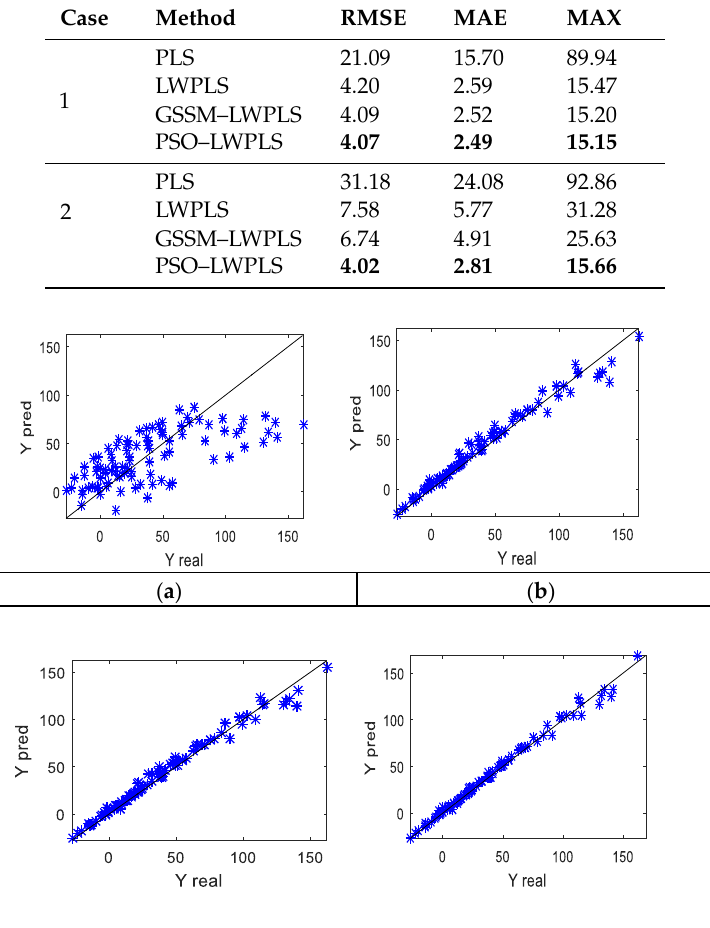
Table 1. Statistical analysis of prediction errors. GSSM: golden section search method, LWPLS: locally weighted partial least squares, MAE: mean absolute error, MAX: maximum absolute error, PLS: partial least squares, PSO: particle swarm optimization.